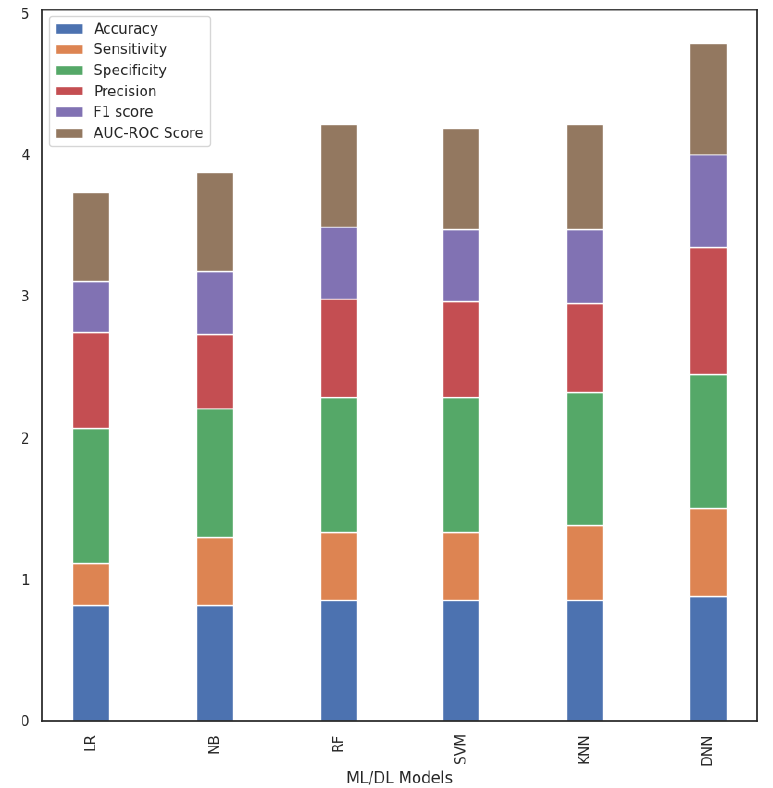
Figure 17. The pictorial representation of comparative performance estimation using different ML/DL models based on the stratified ten-fold cross-validation.